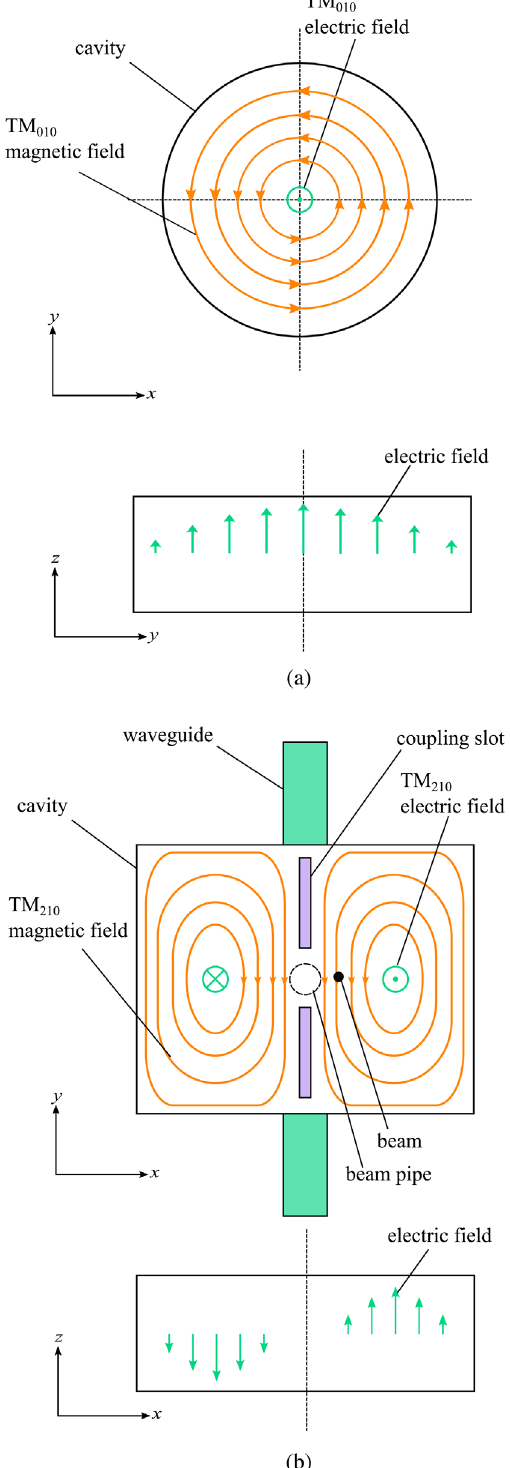
FIG. 2. Schematic of the ATF2 IP region, showing the final- focus magnets including quadrupoles (QF1FF, QD0FF) and sextupoles (SD0FF, SF1FF), and the elements of the FONT IP feedback system including dipole cavity BPMs IPA, IPB and IPC, reference cavity BPMs Ref x and Ref y , and the stripline kicker IPK.